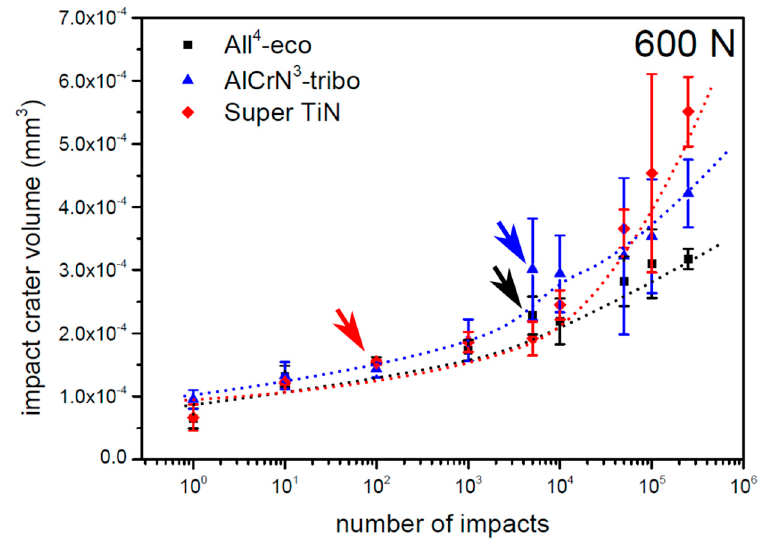
Figure 7. Loading curves of tested PVD coatings obtained by a load of 600 N. Arrows indicates number of impacts where the first cracks appeared.